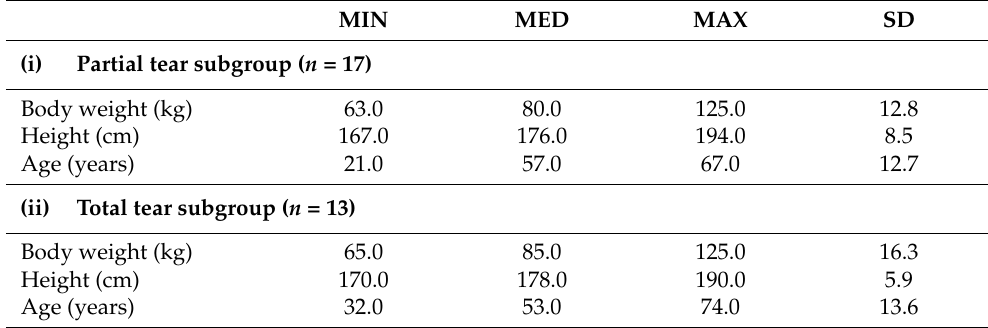
Table 1. Demographic data of the patients enrolled in the